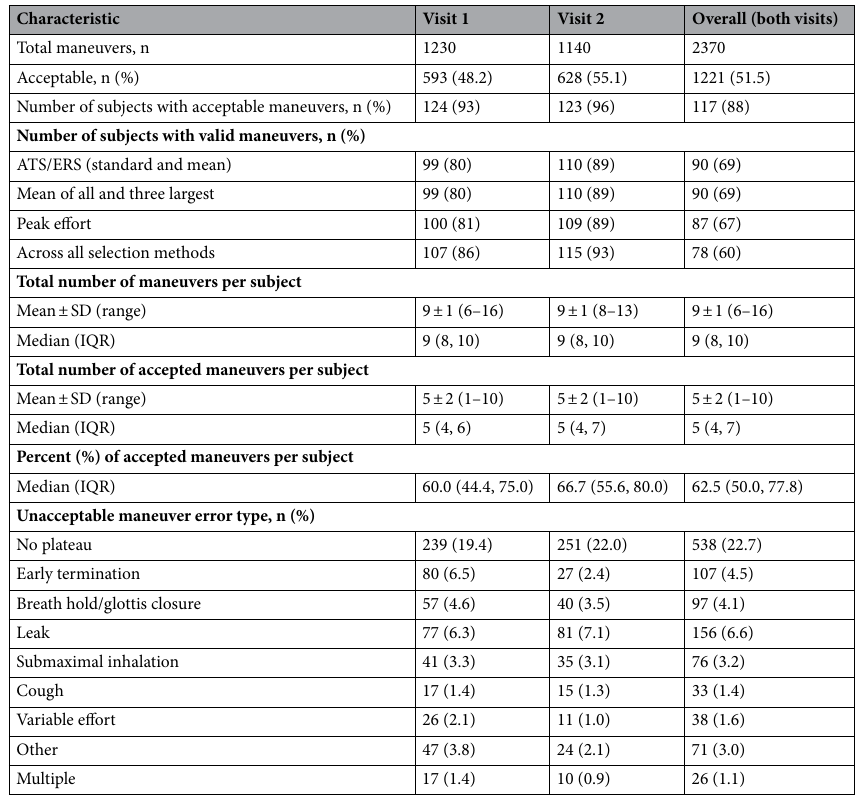
Table 3. Visit and test characteristics. ATS/ERS refers to the current selection method recommended by the American Thoracic and European Respiratory Societies. Data are presented as mean ± 1 standard deviation (SD), median (interquartile range, IQR) or frequency and